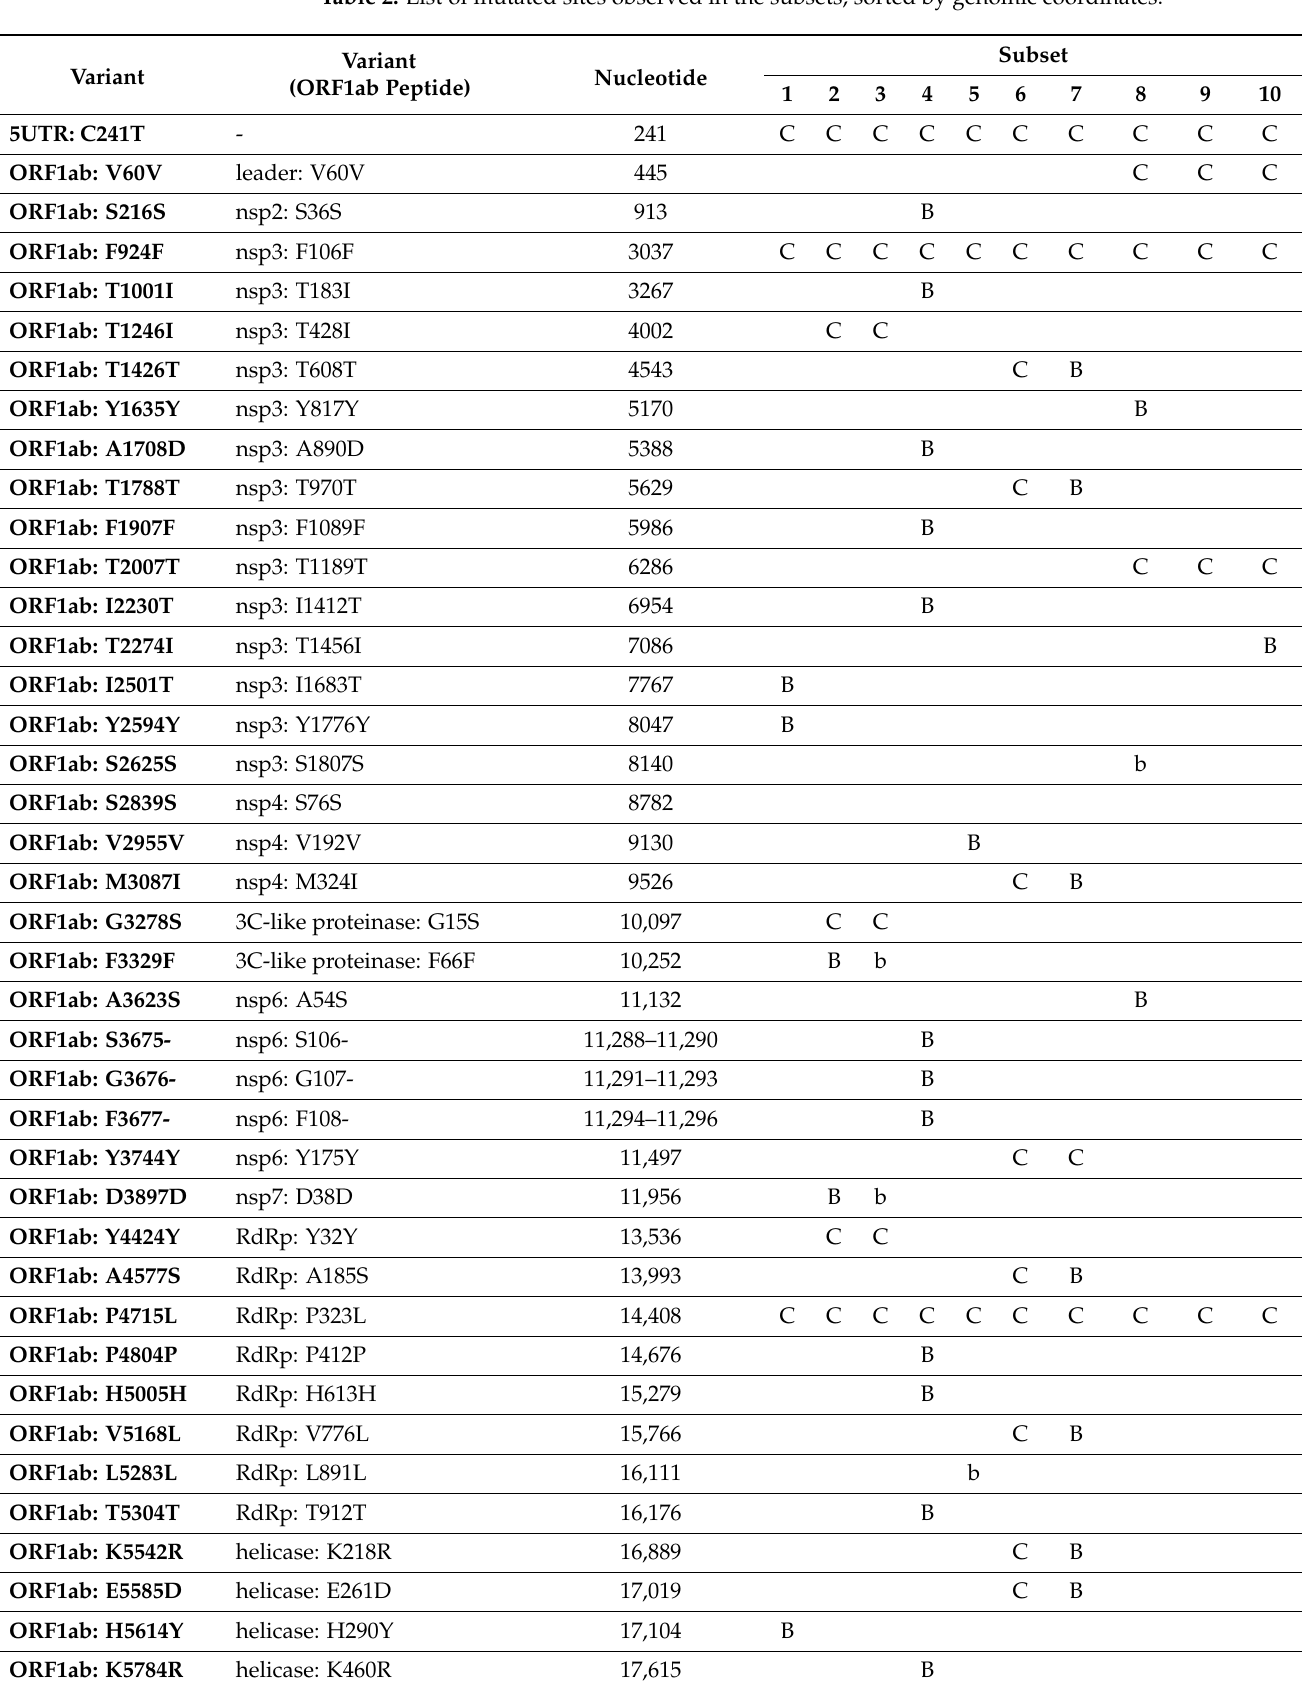
Table 2. List of mutated sites observed in the subsets, sorted by genomic